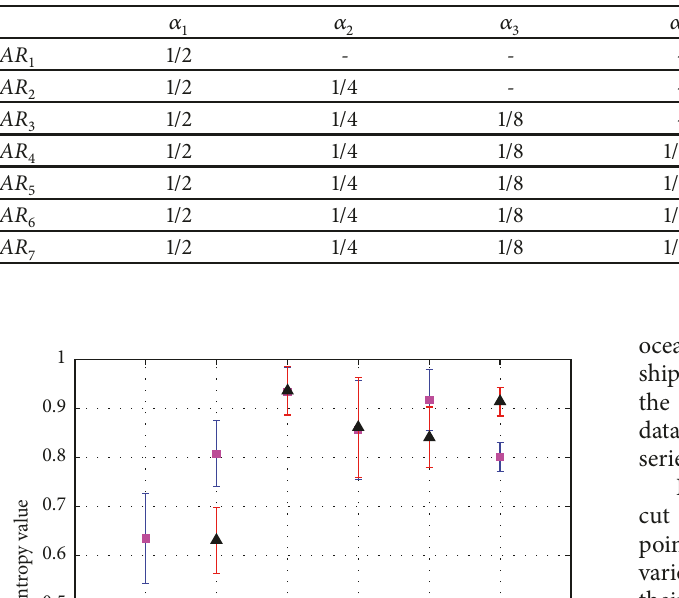
Figure 5: Entropy analysis for time series having spiky features. (a) Waveform of the synthetic signal. (b) Entropy estimation of the synthetic signal. Table 2: The correlation coefficients for generating AR processes.